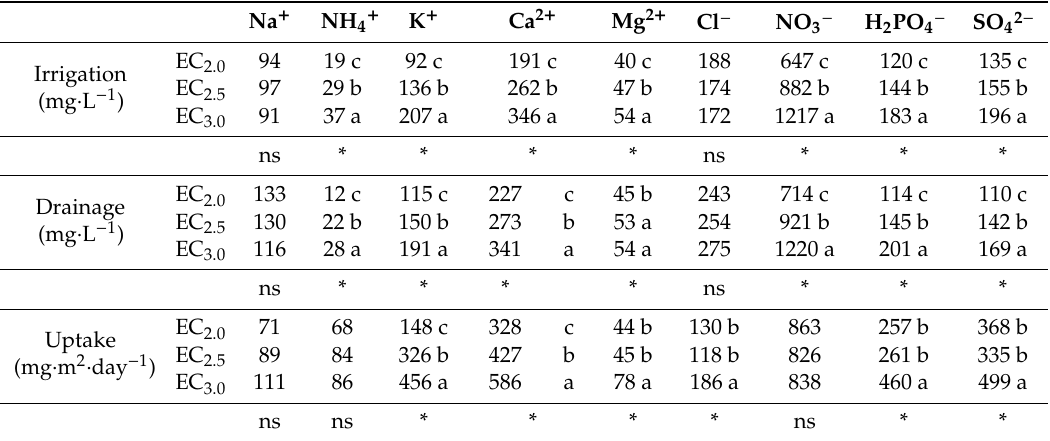
Table 2. Average ionic concentration of irrigation and drainage solutions (mg · L − 1 ) and ion